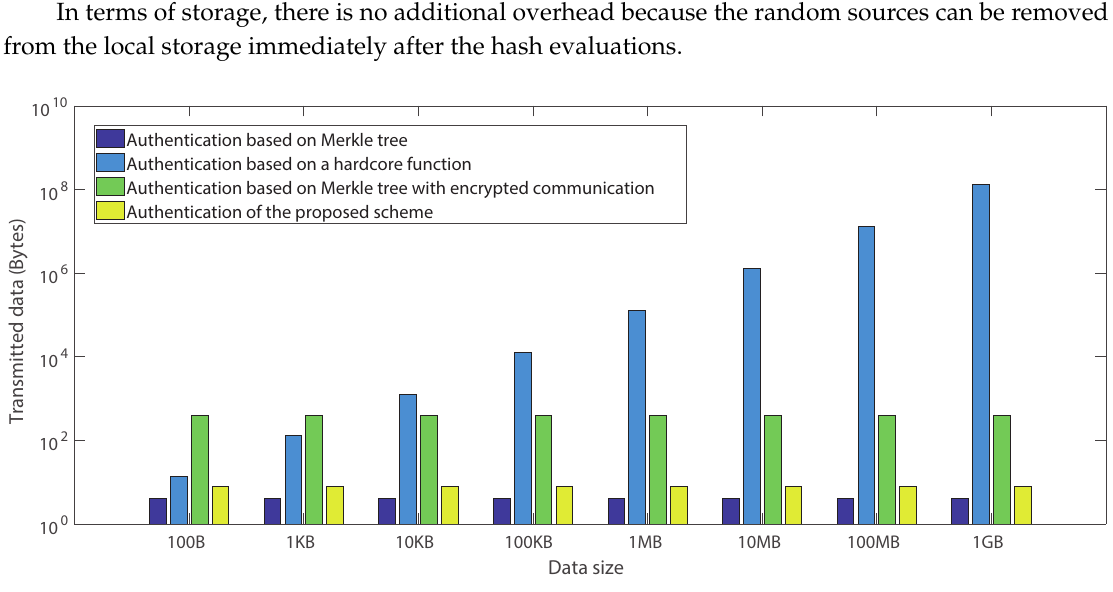
Figure 12. Comparison of trasmitted data on verifier side with varying data